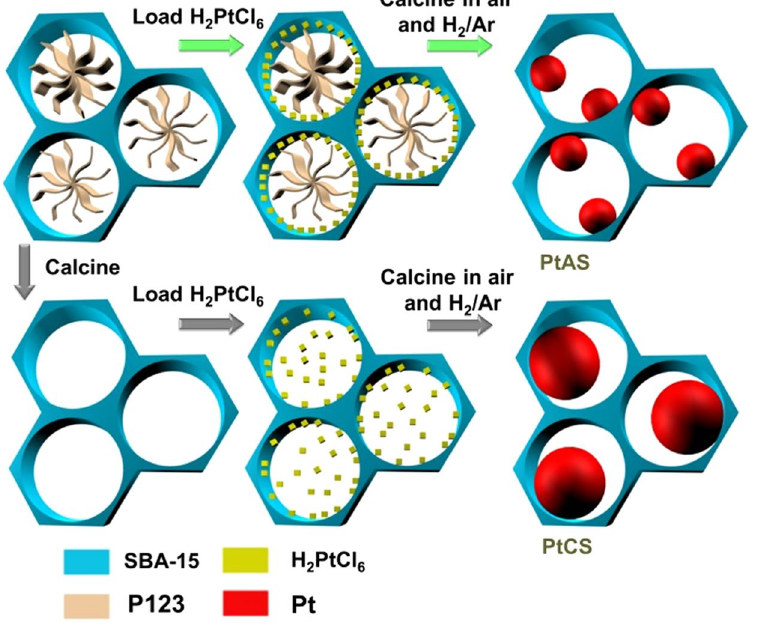
Figure 1. Formation of highly dispersed Pt nanoparticles (PtAS) by using the confined space provided by as synthesized SBA-15, and sparsely dispersed Pt nanoparticles (PtCS) with the template free